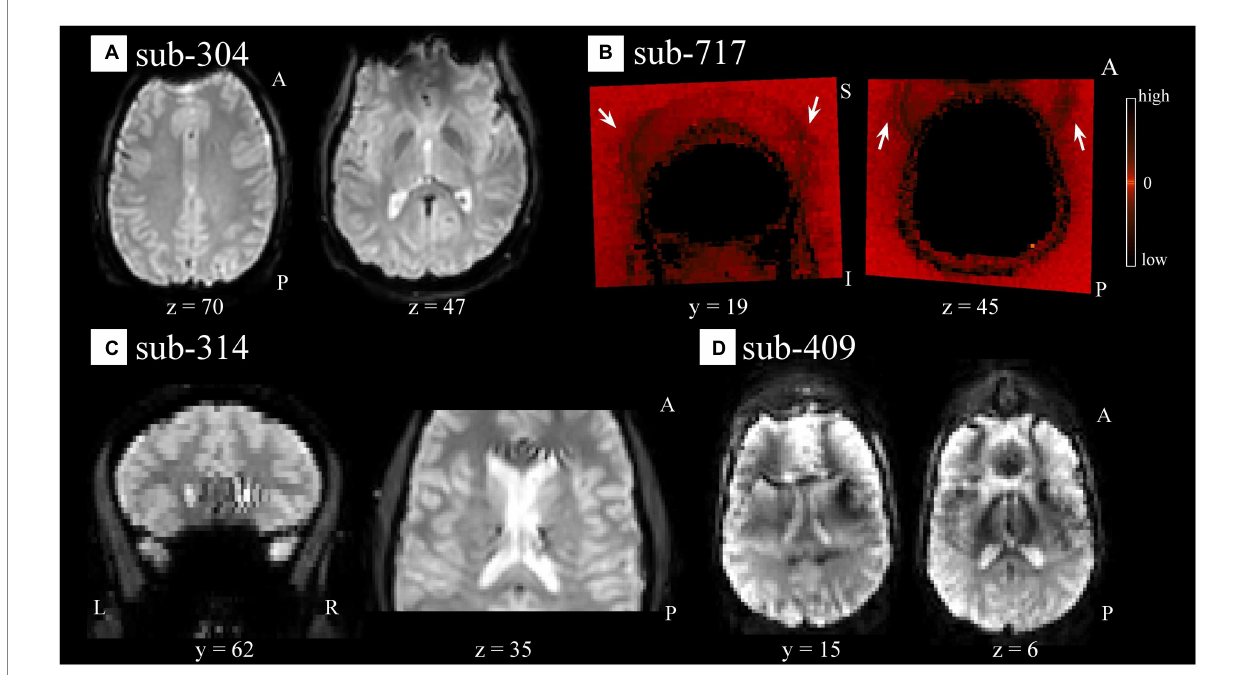
FIGURE 3 Spatial artifacts of raw-level functional data. (A) Spatial distortions and signal drop out in superior/orbito-frontal regions in sub-304 (S44). (B) Aliasing or ghosting in the coronal ( y = 19) and axial ( z = 45) slices from sub-717 (S136). For visualization purposes only, intensity values have been scaled so that low and high values would appear darker, making more evident artifacts such as those highlighted by the white arrows stemming from the superior (left image) and frontal (right image) regions of the head. (C) Unspecified signal inhomogeneity artifacts affecting sub-314 (S54) functional scans localized near areas of high intensity contrast such as CSF to WM. (D) Ghosting, spatial distortions, and signal inhomogeneities are noticeable in sub-409 (S65) functional data across all scans and several slices. For all panels, the images render the first functional scan of raw-level